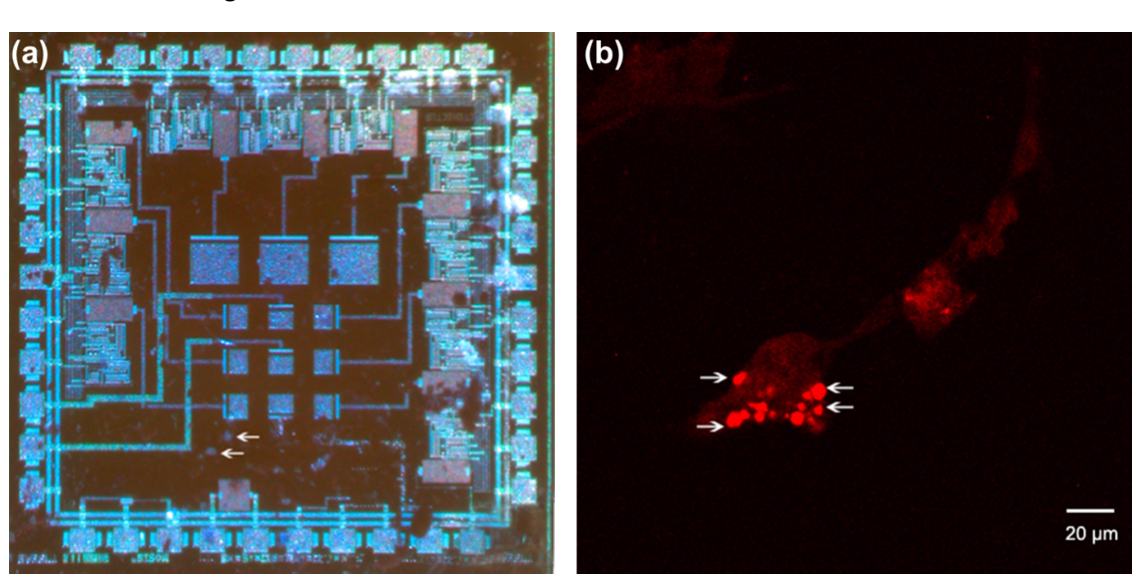
Figure 12. Neurons of vestibular ganglion in newborn rats cultured on the pMEA surface. (a) Microphotograph of a chip upon which neurons had been cultured (arrows) and (b) antineurofilament staining of the cells cultured on the chip. Specific immunostaining with antibodies against the NF-160 demonstrate that cells in the culture are neurons.